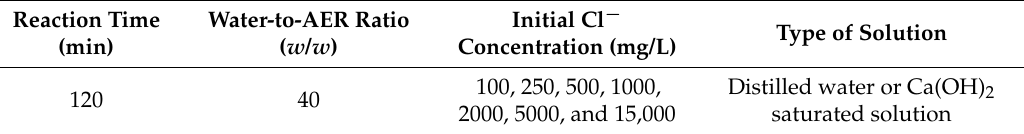
Table 3. Experimental conditions of the equilibrium test in chloride solutions containing the